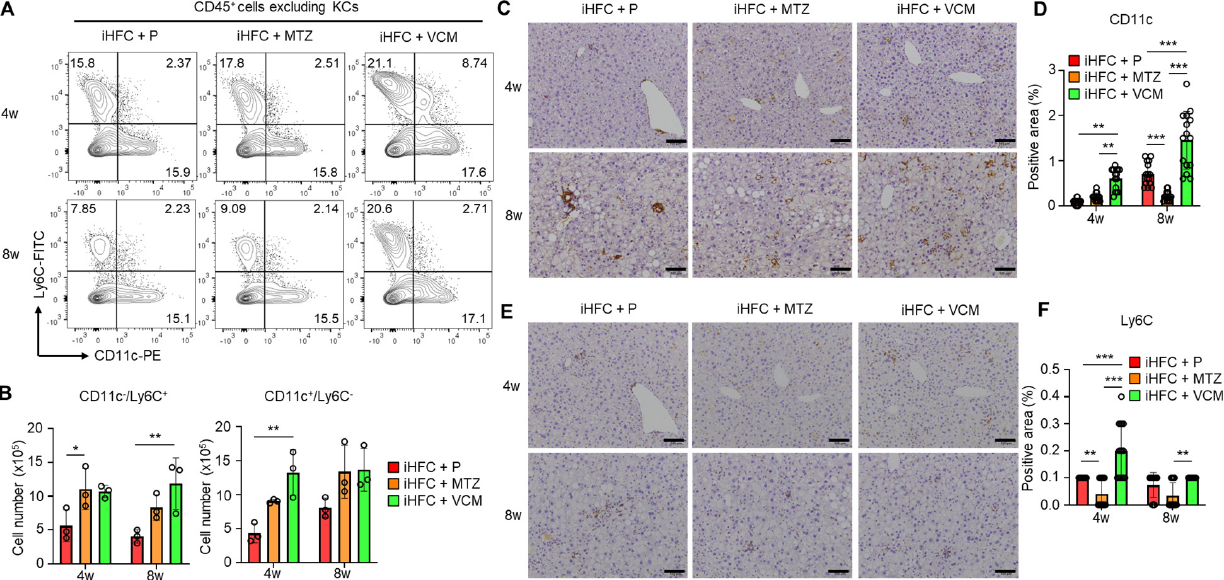
Figure 6. VCM treatment augments iHFC diet-induced accumulation of CD11c + /Ly6C − and CD11c − /Ly6C + -recruited macrophages in the liver of TSNO mice. ( A ) Representative flow cytometry data of CD11c and Ly6C expression on CD45 + non-parenchymal cells excluding KCs of the liver from placebo- or antibiotic-treated TSNO mice. ( B ) Cell numbers of CD11c + /Ly6C − (Left) and CD11c − /Ly6C + (Right)-recruited macrophages were determined by flow cytometry analysis (n = 3 per group). ( C ) Representative histological images of CD11c immunostaining of the liver from placebo- or antibiotic-treated TSNO mice on the iHFC diet. Scale bars, 100 µ m. ( D ) Five locations were photographed in each of three sections in each group. Then, positive areas for CD11c were measured at 15 locations in each group using ImageJ software, and the mean and SD were calculated. ( E ) Representative histological images of Ly6C immunostaining of the liver from placebo- or antibiotic-treated TSNO mice on the iHFC diet. Scale bars, 100 µ m. ( F ) Five locations were photographed in each of three sections in each group. Then, positive areas for Ly6C were measured at 15 locations in each group using ImageJ software, and the mean and SD were calculated. Data are shown as means ± SD. * p < 0.05, ** p < 0.01, *** p < 0.001.